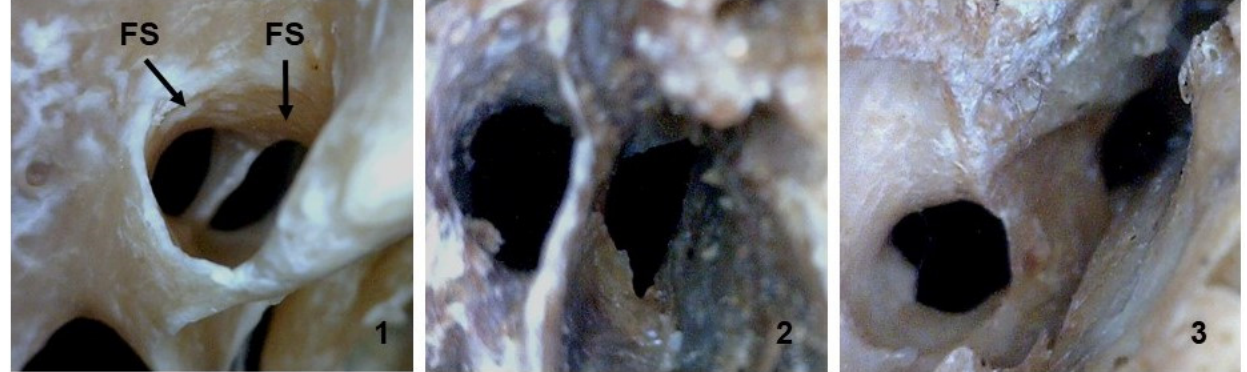
Figure 7. Inferior view of the skull. Note the division ( 1 ) and duplication in different shapes ( 2 , 3 ) of the foramen spinosum (FS).